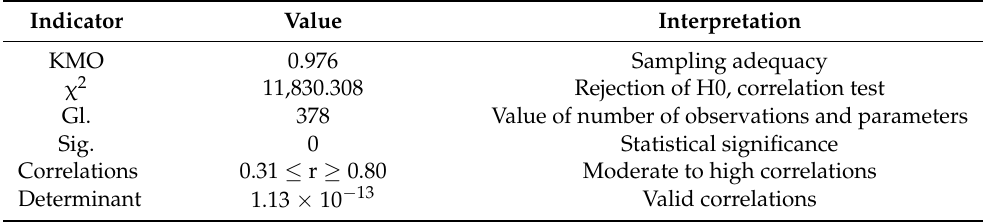
Table 14. Preliminary factorial results of ethical values in productivity.